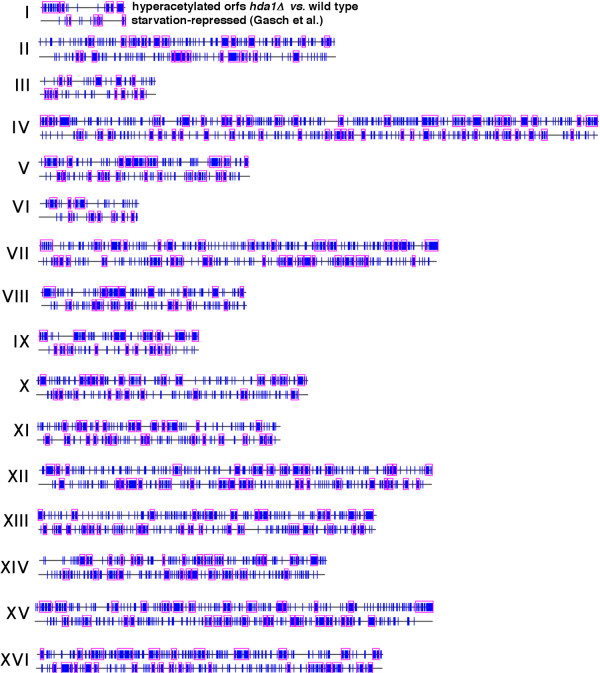
Clusters of genes repressed by starvation less frequently contain genes enriched for histones deacetylated by Hda1p. Vertical blue lines indicate the position of genes repressed by starvation (bottom gene map for each chromosome) or that are enriched for histone H3 acetylated on K18 in hda1Δ compared to wild type cells (top map for each chromosome). Pink rectangles indicate clusters of genes detected by Pyxis in each dataset that are unlikely to have formed by chance (p ≤ 0.05). Roman numerals indicate chromosome number.